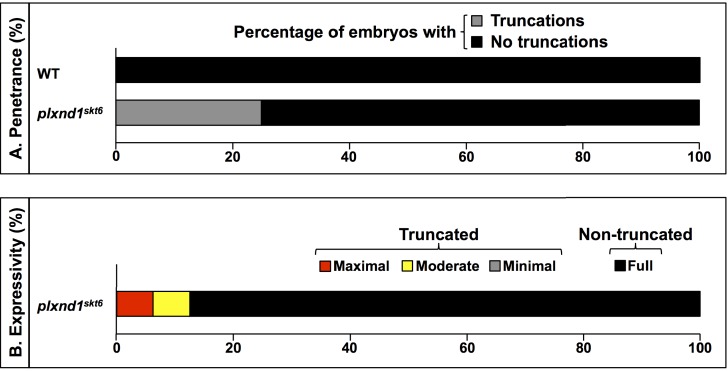
Penetrance and expressivity of Se-DLAV truncations in plxnd1skt6 mutants at 32 hpf.(A) Penetrance bar graph. Percentage of embryos of the indicated genotypes with Se-DLAV truncations (gray; a summation of the ‘minimal,’ ‘moderate,’ and ‘maximal’ categories) and with non-truncated Se-DLAV (black; ‘full’ category). The distributions of these two phenotypic classes were not statistically significantly different between WT and plxnd1skt6 mutants as assessed by a two-sided Fisher Exact test, p=0.21739. (B) Expressivity bar graph. Percentage of ‘maximal’ (red), ‘moderate’ (yellow), and ‘minimal’ (gray) Se-DLAV truncations, and of ‘full’ (black) non-truncated Se-DLAV in plxnd1skt6 mutants with Se-DLAV truncations. For additional supplementary information related to this figure, see Supplementary file 3. This figure is related to Figure 2.